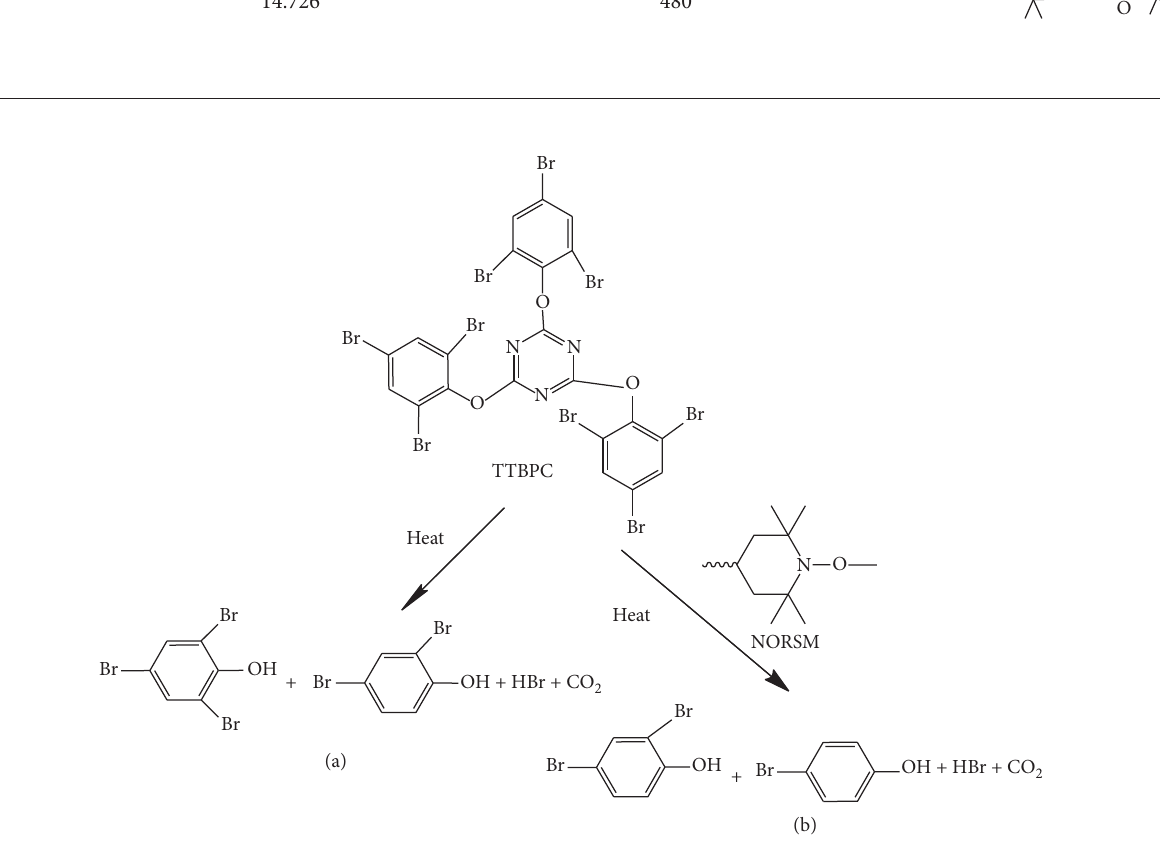
Scheme 2: Pyrolysis pathways of